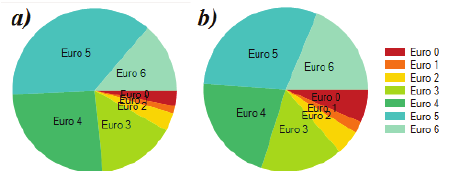
Fig. 3. Emission classes for selected vehicles; a)passenger car’s b)trucks and buses The modelled variants of roundabout intersections are presented in Figures 4 and 5.